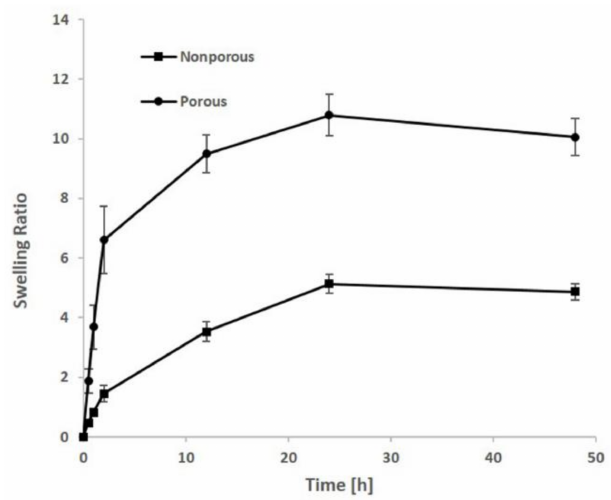
Figure 5. Swelling ratio of both porous and non-porous hydrogels after various soaking time in phosphate-buffered saline (PBS)-based solution.